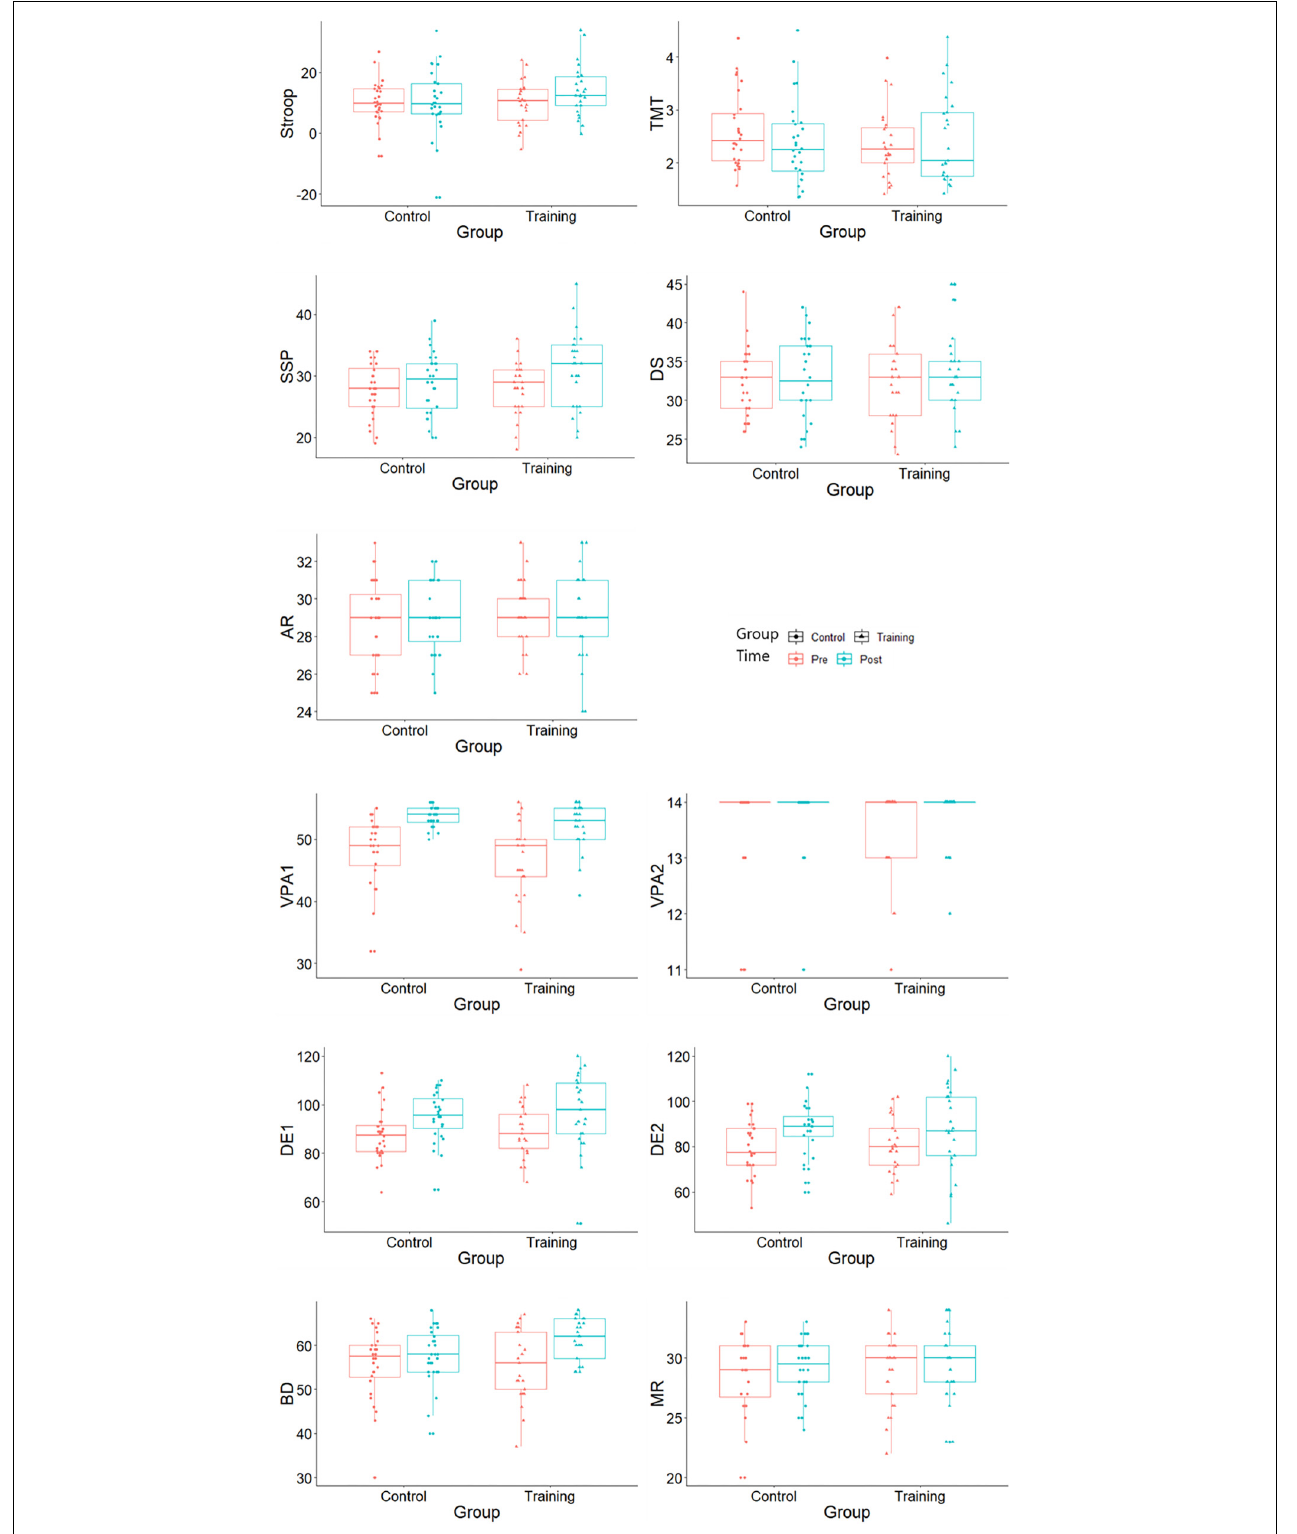
FIGURE 1 | Cognitive test scores at baseline and after training. Stroop, Stroop interference score; TMT, Trail Making Test interference index; SSP, Symbol Span; DS, Digit Span; AR, Arithmetic; VPA1, Verbal Paired Associate immediate recall; VPA2, Verbal Paired Associated delayed recall; DE1, design immediate recall; DE2, design delayed recall; BD, Block Design; and MR, Matrix